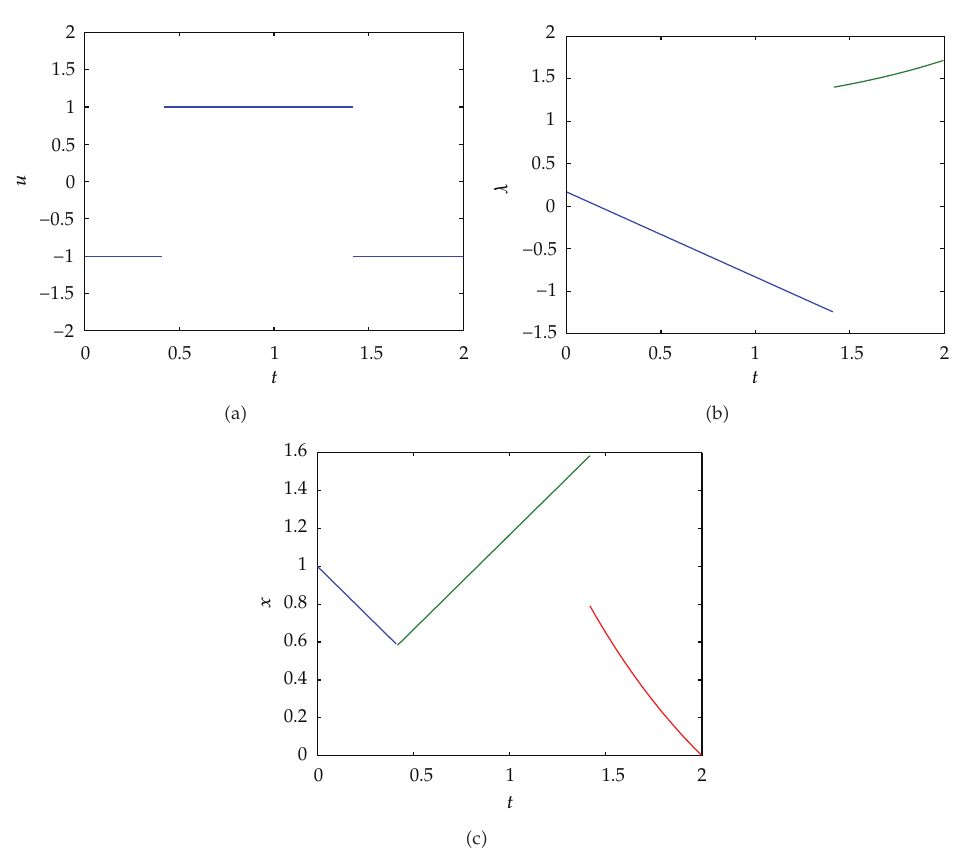
Figure 2: Control, adjoint, and state variable in the Example